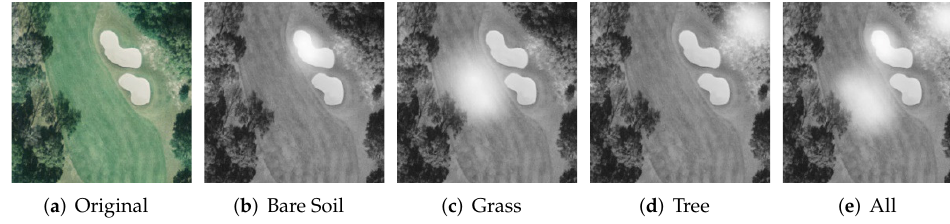
Figure 5. The picture “golfcourse79” in UC-Merced [16,17] dataset and its attention parts generated by RMAM.